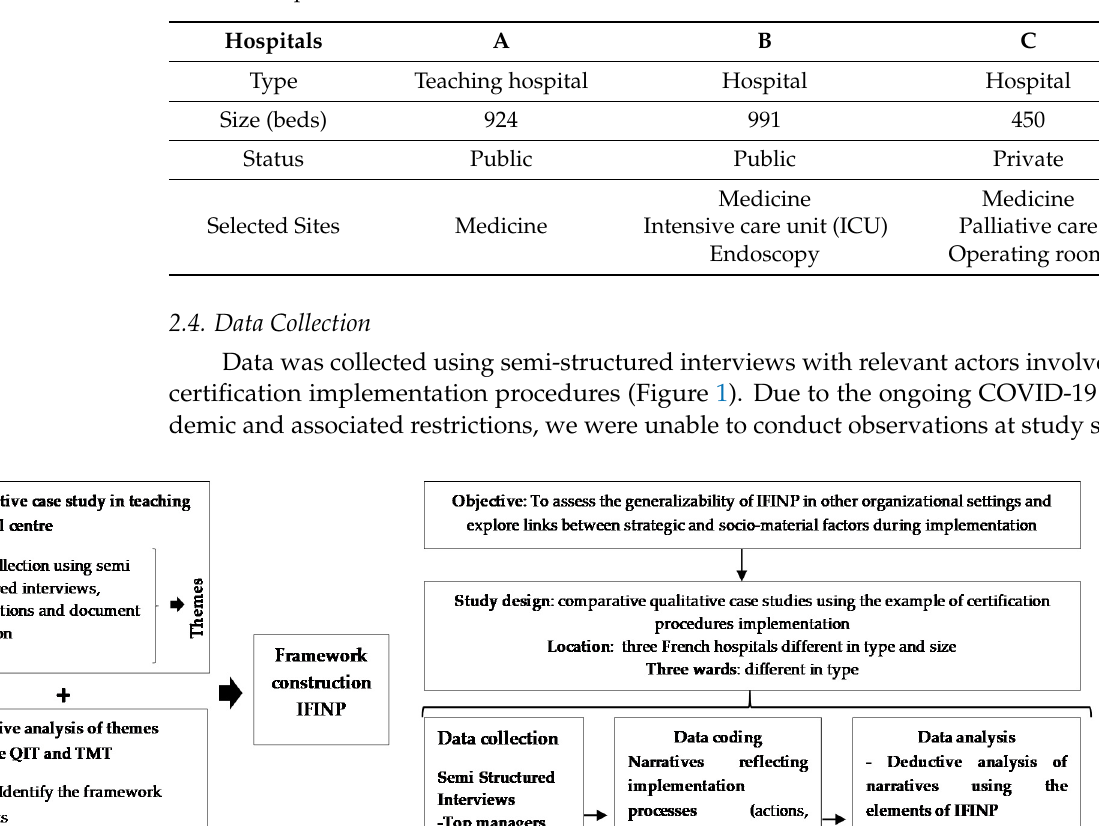
Table 1. Hospital characteristics.